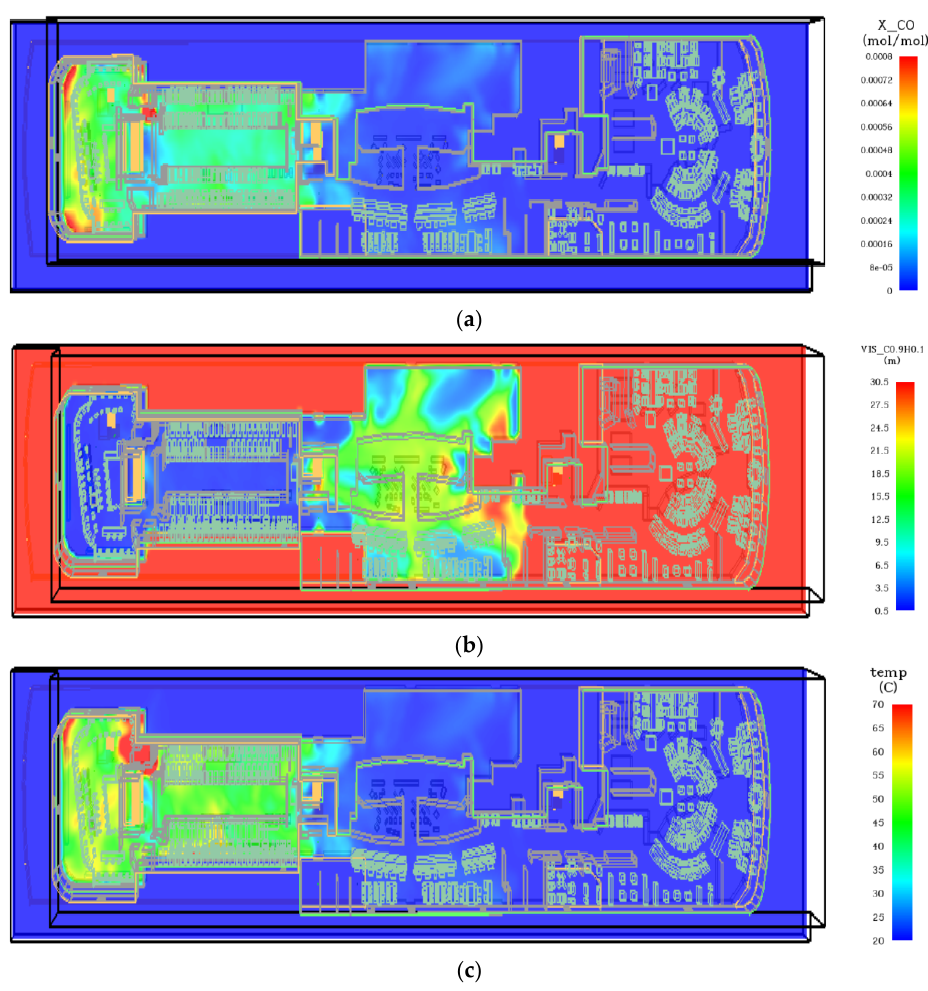
Figure 4. The heat map of CO concentration, visibility, and temperature corresponding to the fire at the 200th second. ( a ) The heat map of CO concentration; ( b ) The heat map of visibility; ( c ) The heat map of temperature. Table 3. Dynamic change data of the cruise ship risk level under fire situation.